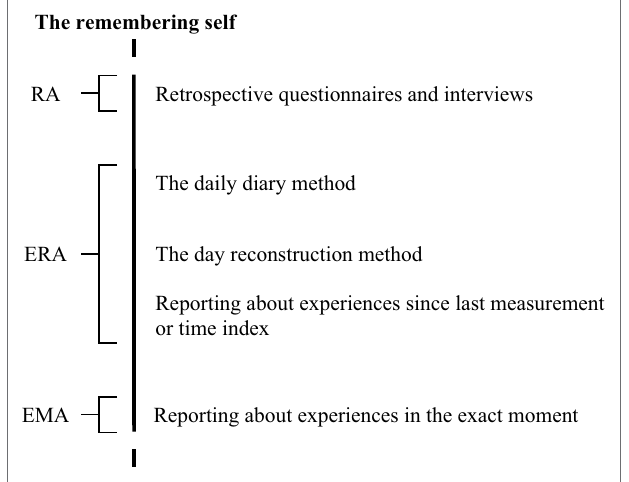
FIGURE 1 | Different data collection procedures on the continuum from the RS to the ES. RA, Retrospective Assessment, in which participants need to summarize remembered experiences over a prolonged period. ERA, Ecological Retrospective Assessment, in which participants need to sequentially summarize remembered experiences over a shorter period. EMA, Ecological Momentary Assessment, in which participants report on their current experiences